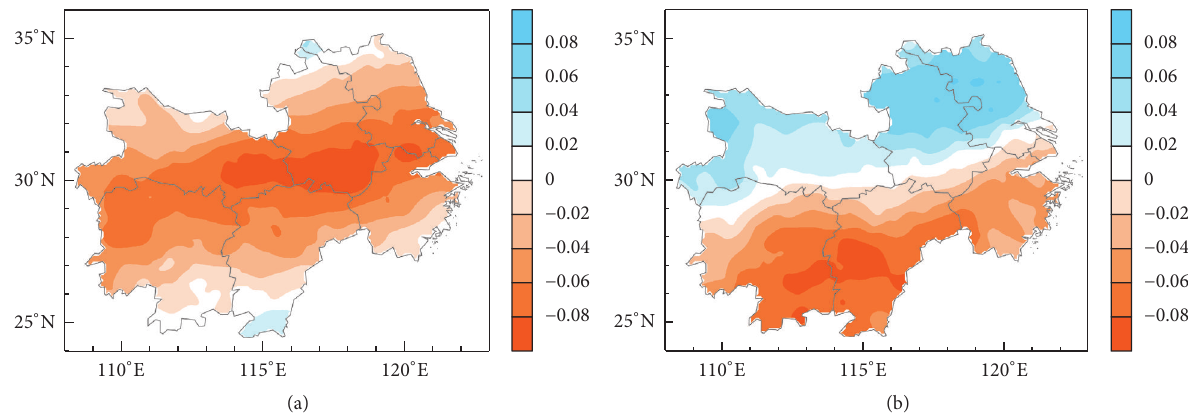
Figure 2: The distribution of the first two Empirical Orthogonal Function (EOF) modes of the Standardized Precipitation Index (SPI) for a 3-month time scale (SPI3) in August, derived for the period 1961–2013: (a) EOF1, (b)